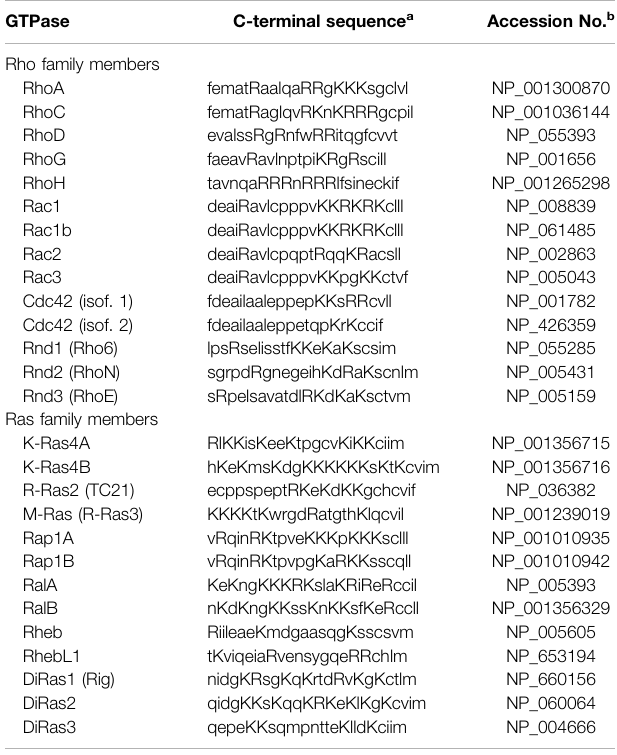
TABLE 1 | C-Terminal Sequences of Human Ras and Rho Family Members that have a Polybasic Region (PBR).